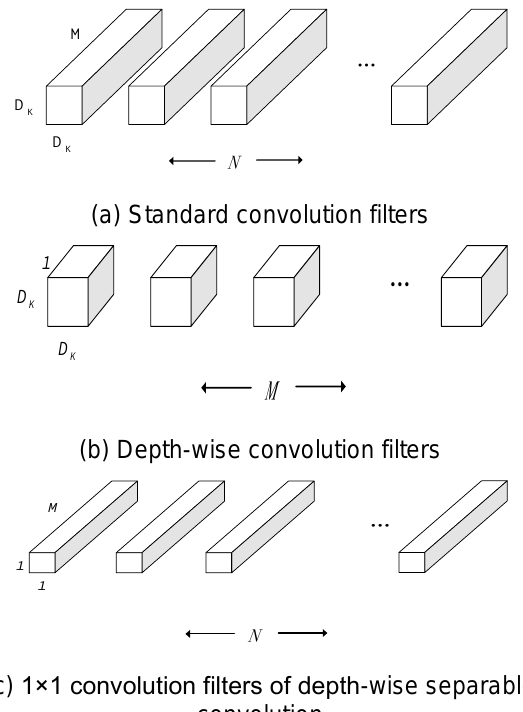
Figure 2. Deeply separable convolution